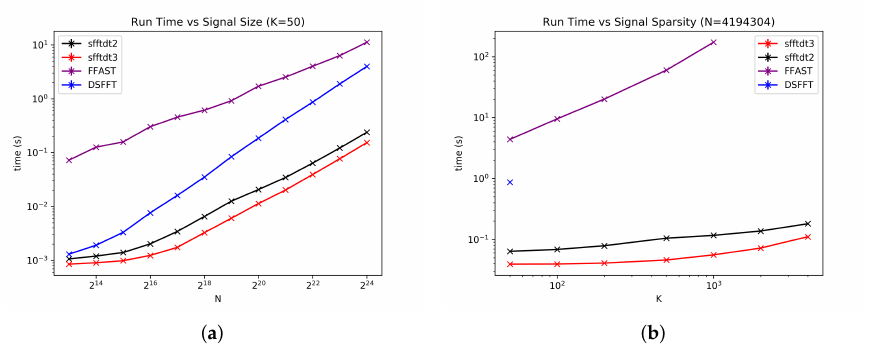
Figure 6. The run time vs. signal size and vs. signal sparsity for the sFFT-DT2.0, sFFT-DT3.0, DSFFT, and R-FFAST algorithm in the general sparse case. ( a ) run time vs. signal size; ( b ) run time vs. signal